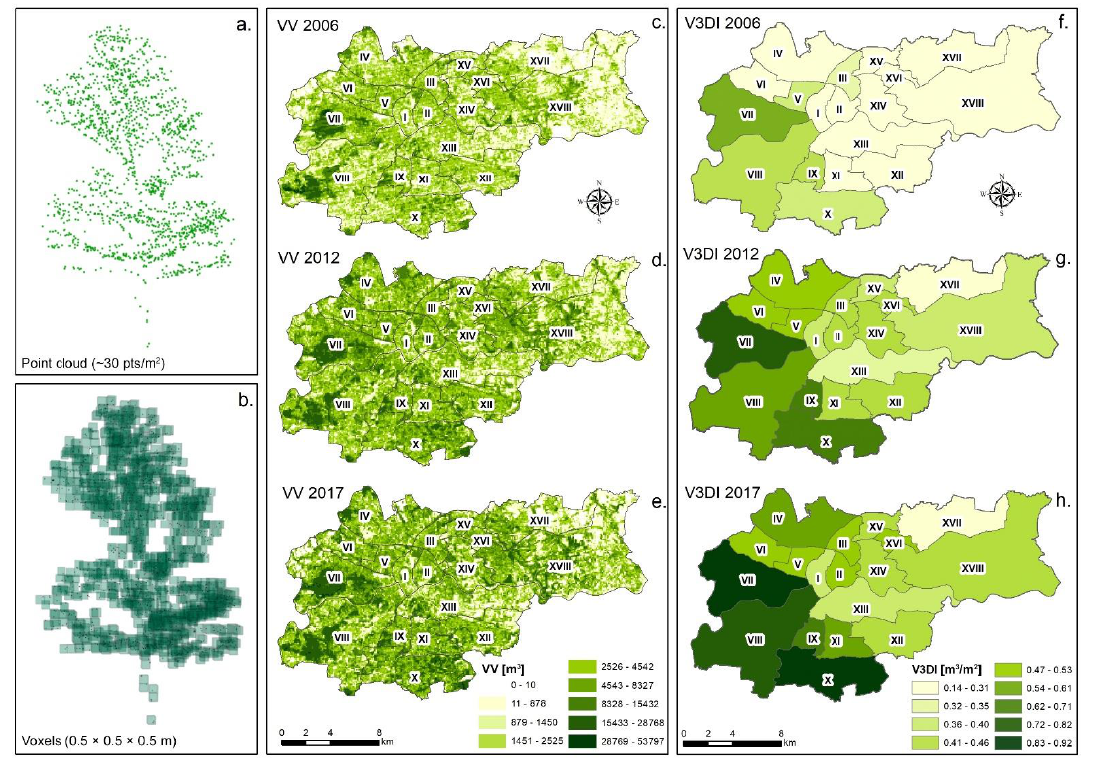
Figure 7. Vegetation volume based on the ALS point cloud ( a ) converted into 0.5 m × 0.5 m × 0.5 m (x, y, z) voxels ( b ). Maps of the Vegetation Volume (VV) as the sum volume of voxels in 2006 ( c ), 2012 ( d ), and 2017 ( e ), and the Vegetation 3D Density Index (V3DI) in the Krakow city districts (I-XVIII) in 2006 ( f ), 2012 ( g ), and 2017 ( h ). Table 4. Vegetation Volume (VV) and Vegetation 3D Density Index (V3DI) calculated for the Krakow districts for 2006, 2012, and 2017.